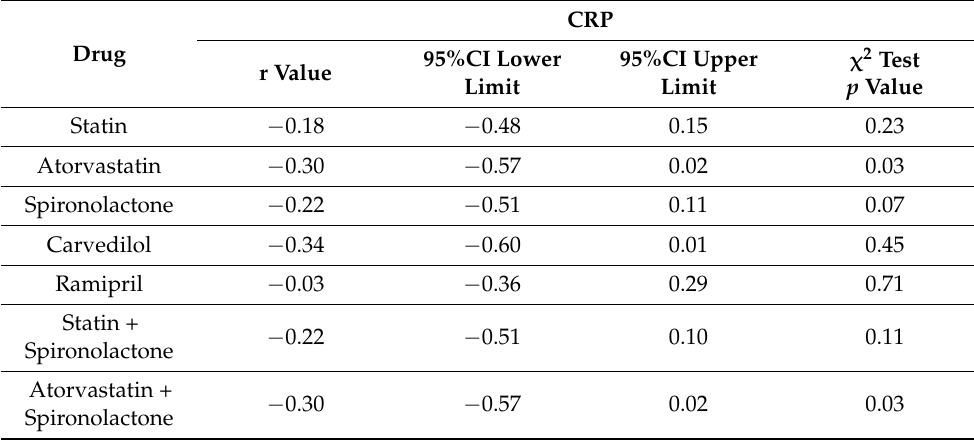
Table 6. Correlation/association between drug therapy and concentration levels of